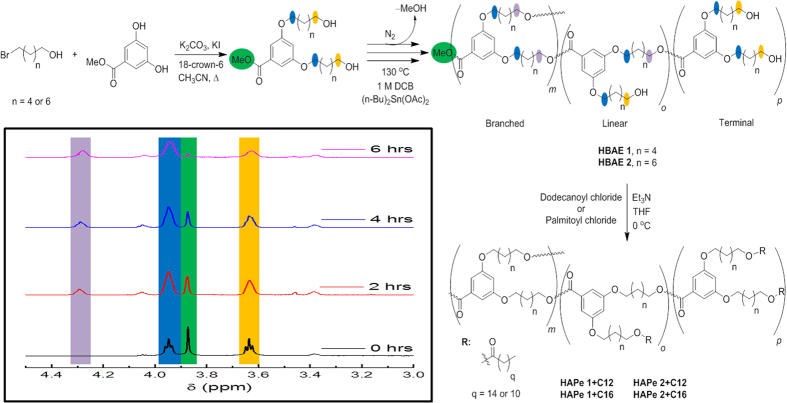
Synthetic route towards novel comb-burst hyper-branched aryl polyesters (HAPe), subsequent post-modification, and stacked 1H-NMR spectrum illustrating progression of polymerization.